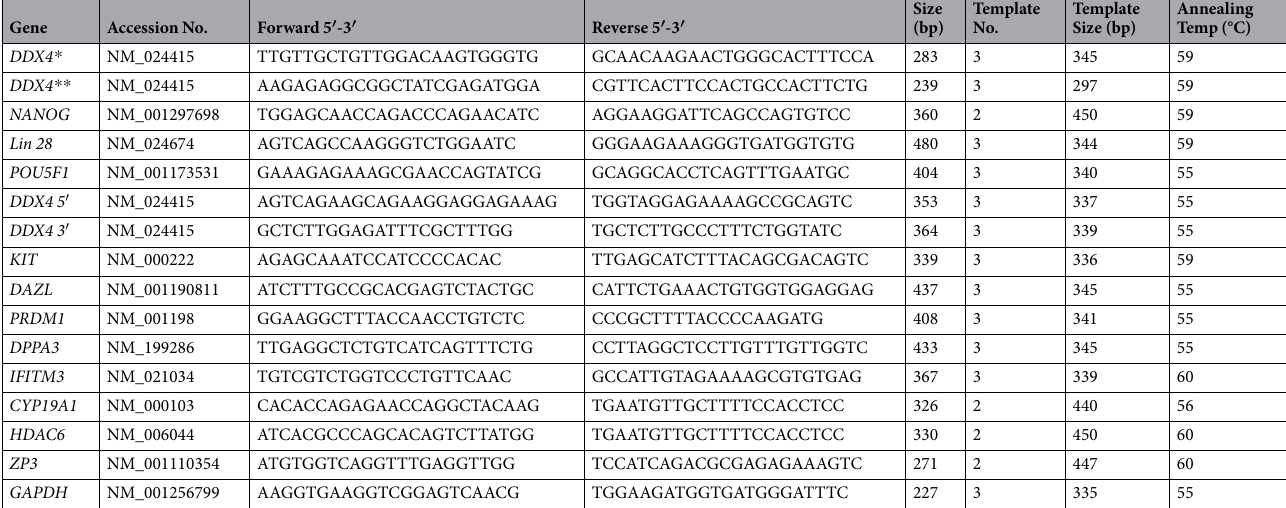
Table 1. Details of Primer Sequences. * Primer sequence from White et al . 5 . ** Primer sequence from Anderson v et al . 27